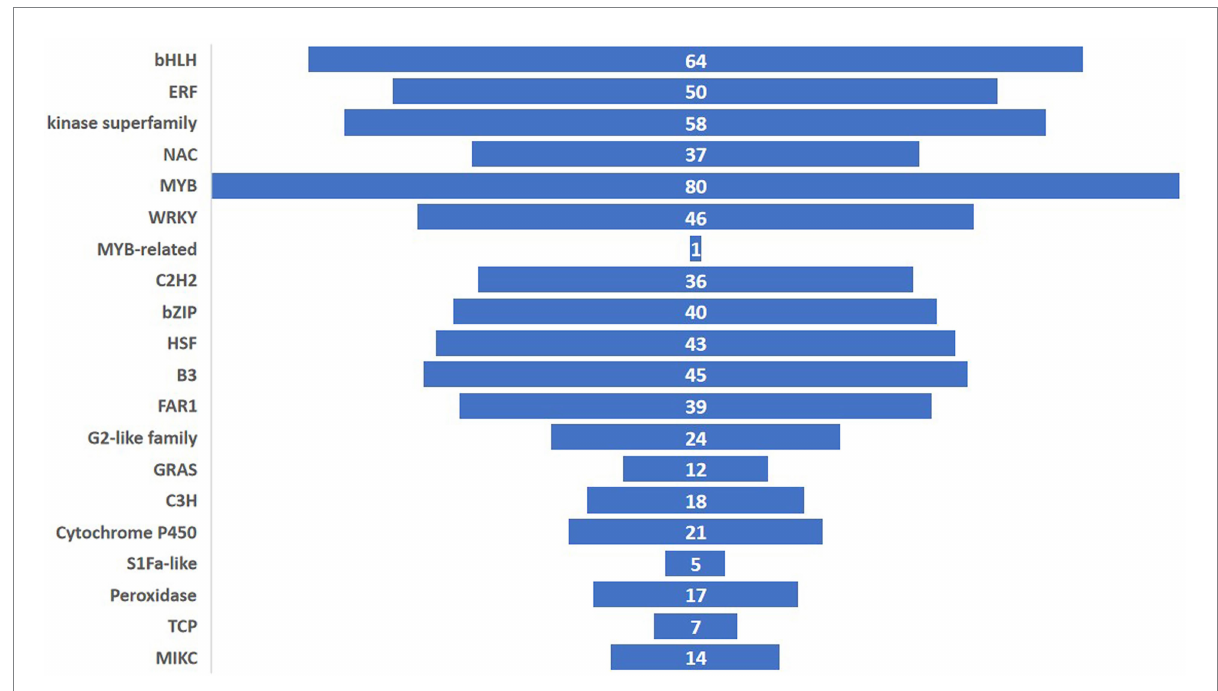
FIGURE 8 Number of pathogen-induced transcription factors for each family in ICMB 93333 at different time-points after inoculation with M. grisea